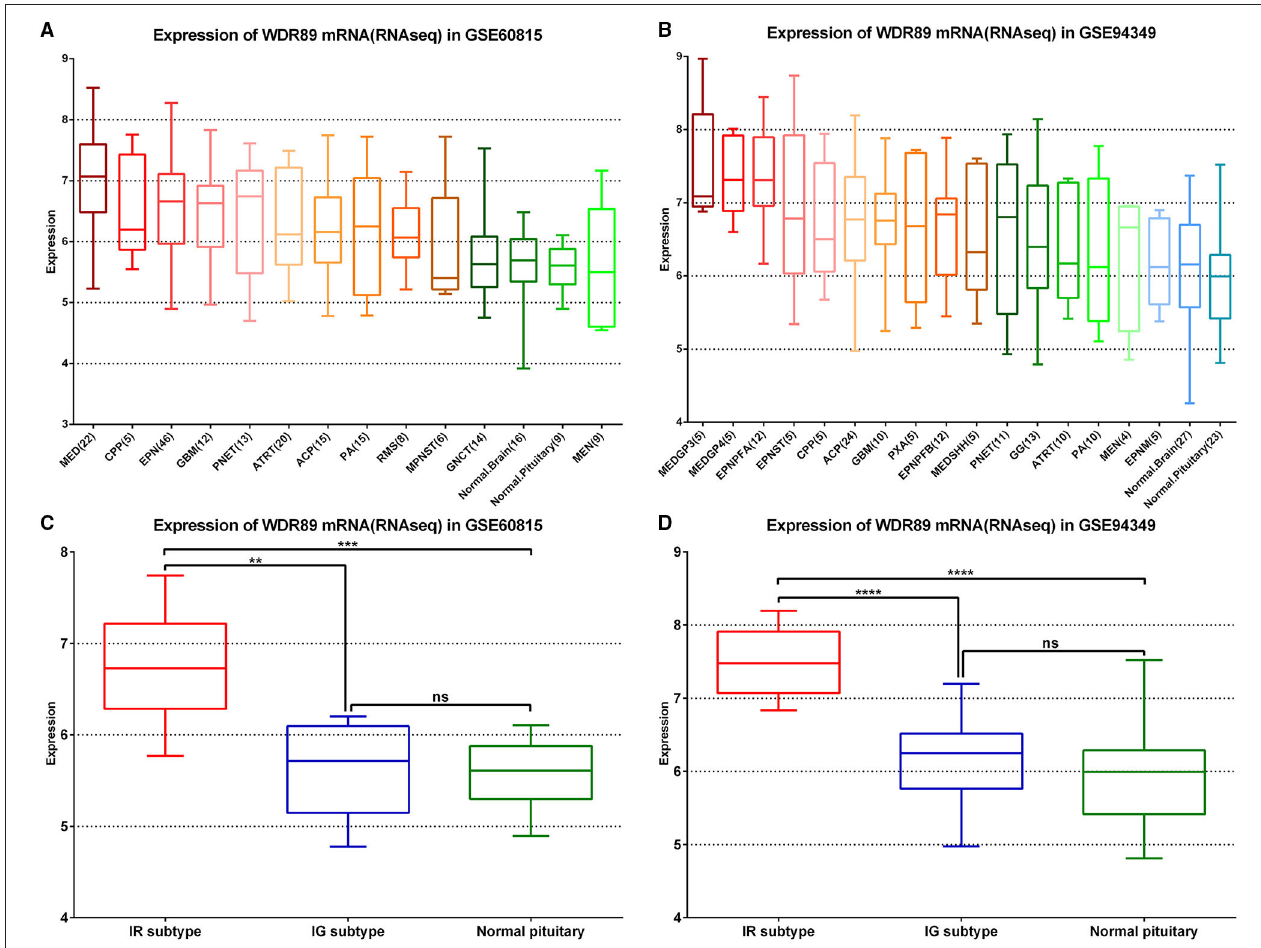
FIGURE 9 | WDR89 related expression profile in ACPs relative to a broad range of pediatric and adult brain tumor types. (A,B) WDR89 mRNA expression in ACPs relative to a broad range of pediatric and adult brain tumor types in the GSE68015 and GSE94349 databases. (C,D) Expression of WDR89 in the IG and IR subtype of ACPs, and normal pituitary group. **p < 0.01, ***p < 0.001, ****p <